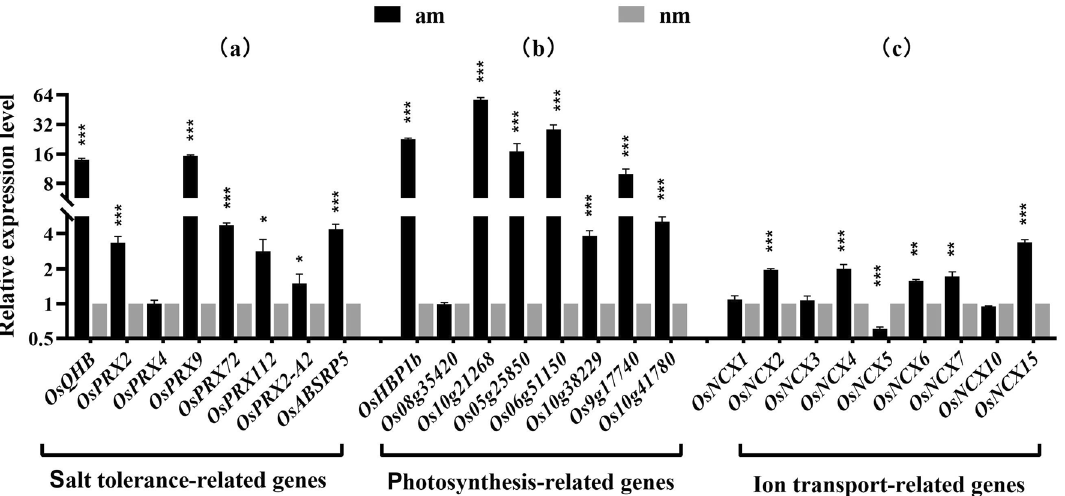
Fig. 6 The relative gene expression of the am 80 treatment group and nm 80 treatment group. Note: a Relative expression of genes related to salt tolerance, b Relative expression of genes related to photosynthesis, c Relative expression of genes related to ion transport; * indicates the difference between different inoculation treatments when the same gene is treated (* P < 0.05; * * P < 0.01; *** P < 0.001)